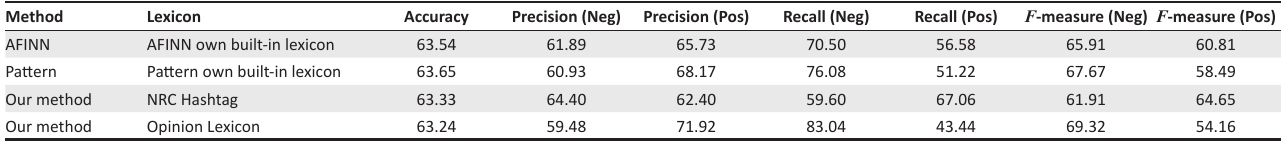
TABLE 1: Summary of sentiment classification results (in percentages).